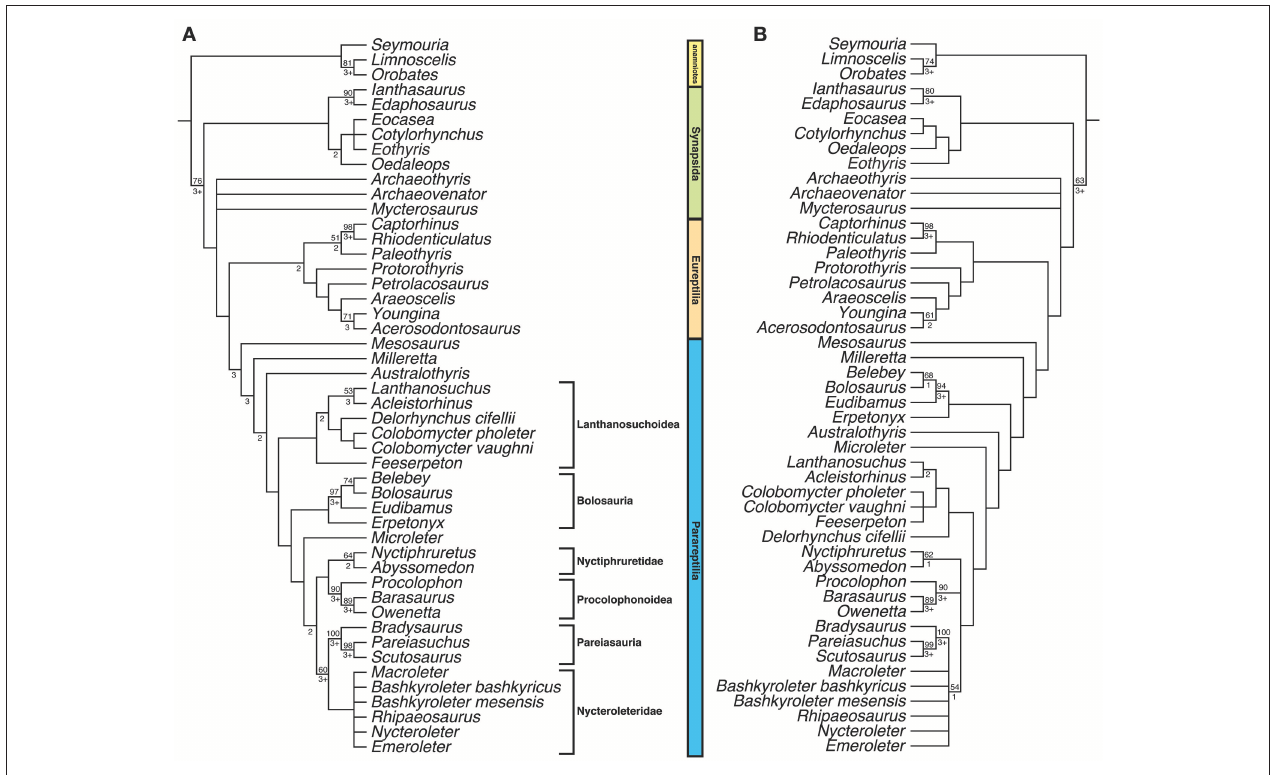
FIGURE 1 | Strict consensus trees found in the phylogenetic analyses. (A) Strict consensus of 9 optimal trees obtained from the analysis that included all characters, tree length = 669, consistency index (CI) = 0.302, rescaled CI = 0.195, retention index = 0.646; (B) Strict consensus of 14 optimal trees obtained from the analysis that removed all temporal fenestration characters, tree length = 638, CI = 0.303, rescaled CI = 0.195, retention index = 0.646. Bootstrap support values (based on 1,000 replicates) are found above nodes, if no value is present it was < 50%. Bremer support values are found below nodes, if no value is present the clade collapsed with the addition of one extra